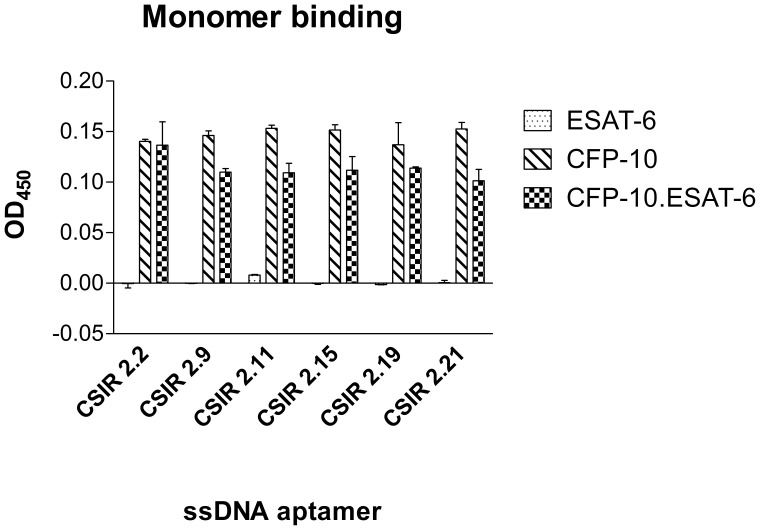
Binding affinity of the selected ssDNA aptamers to CFP-10 and ESAT-6.Binding of the anti-CFP-10.ESAT-6 biotinylated ssDNA aptamers to the ESAT-6 and CFP-10 monomers was determined by an ELONA. Binding of the ssDNA aptamers to the CFP-10.ESAT-6 heterodimer is shown for comparative purposes. Data are presented as means ± standard deviation of the mean.